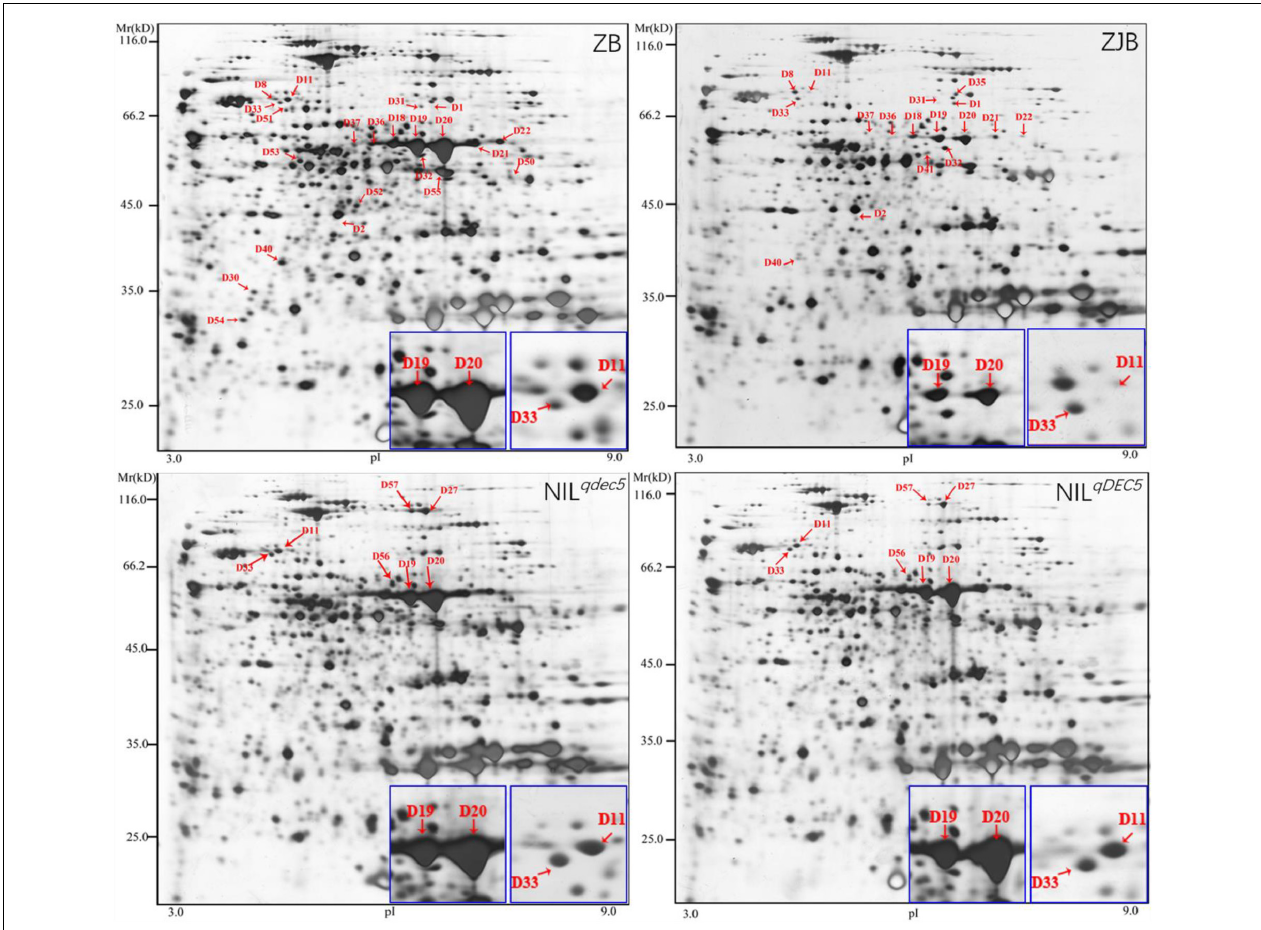
FIGURE 8 | 2-DE maps at 12 DAP. Red arrows indicate the positions of protein spots showing differential expression. The blue box is an enlarged view of the corresponding protein spots in the